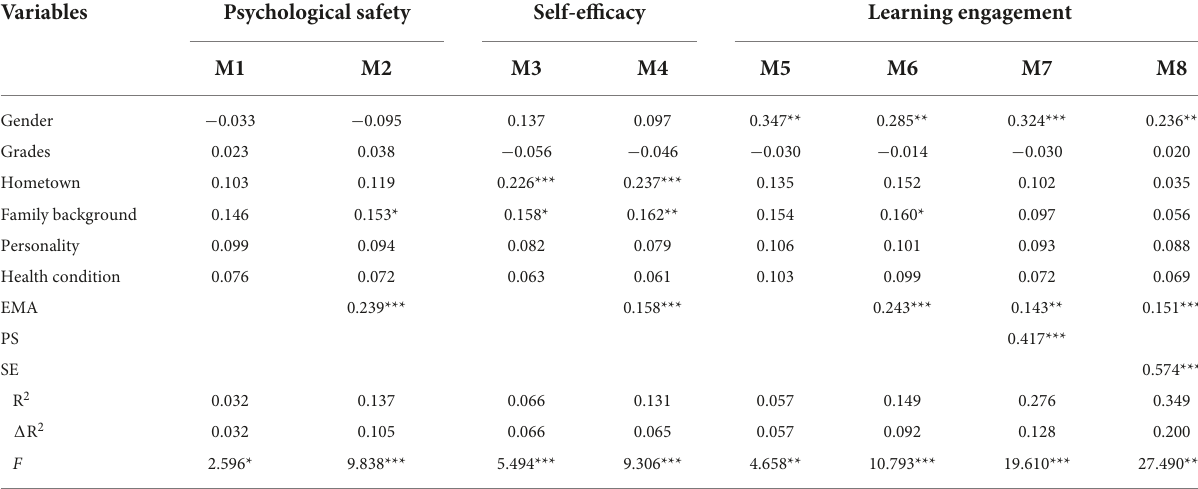
TABLE 3 Results of hierarchical regression analysis.